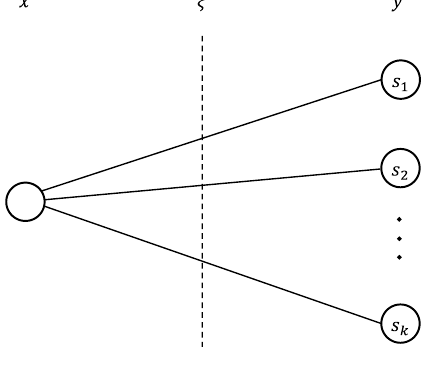
Figure 3. Scenario representation.